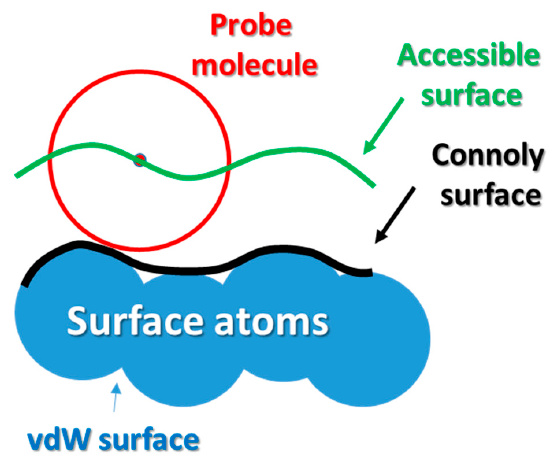
Figure 9. Graphical representation of the Connolly and accessible surface. The probe molecule represented as sphere of given radius is being rotated on the surface defined by the van der Walls spheres of the constituent elements of given material. The center of probe molecule defines the Connolly surface.